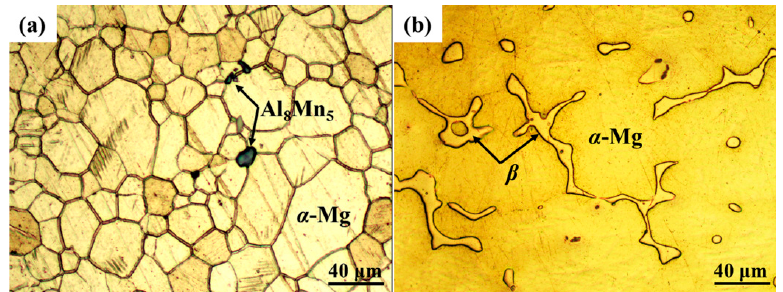
Figure 1. Optical micrographs of the bare AZ31 ( a ) and AZ91 ( b ) Mg alloys.